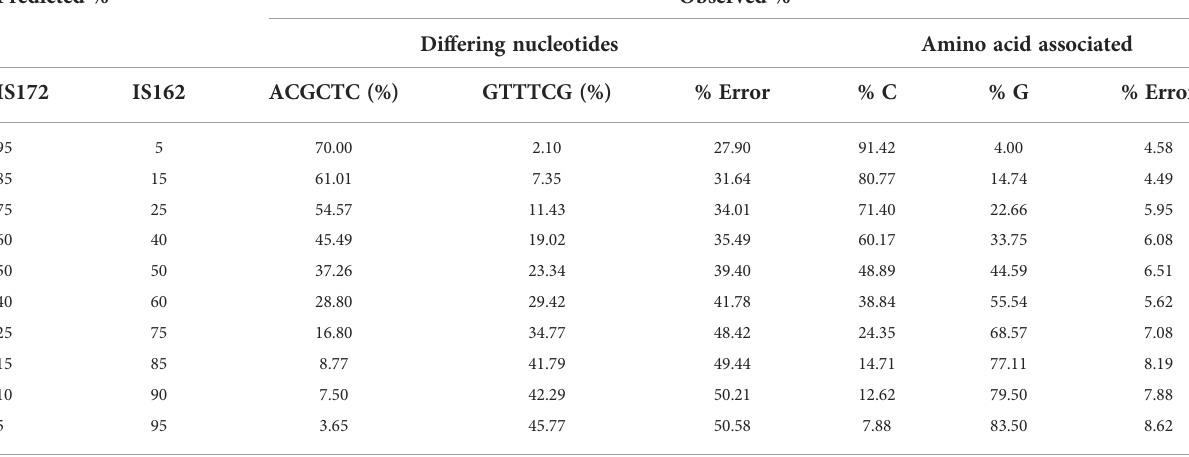
TABLE 4 Summary of the observed versus predicted percentages for each isolate based on the six nucleotides which differ between the two isolates (IS172/ACGCTC versus IS162/GTTTCG) and just analysing the SNP which translate into a different amino acid. Predicted % Observed %